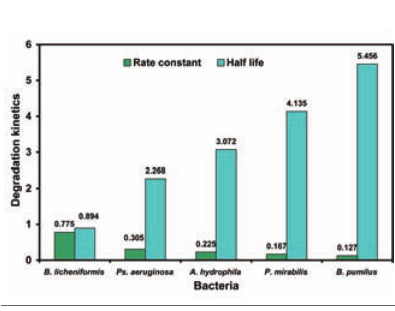
Figure 4. Kinetics, expressed as rate con- stant (per 24 h) and half life (day), of dimethoate degradation reaction using the bacterial